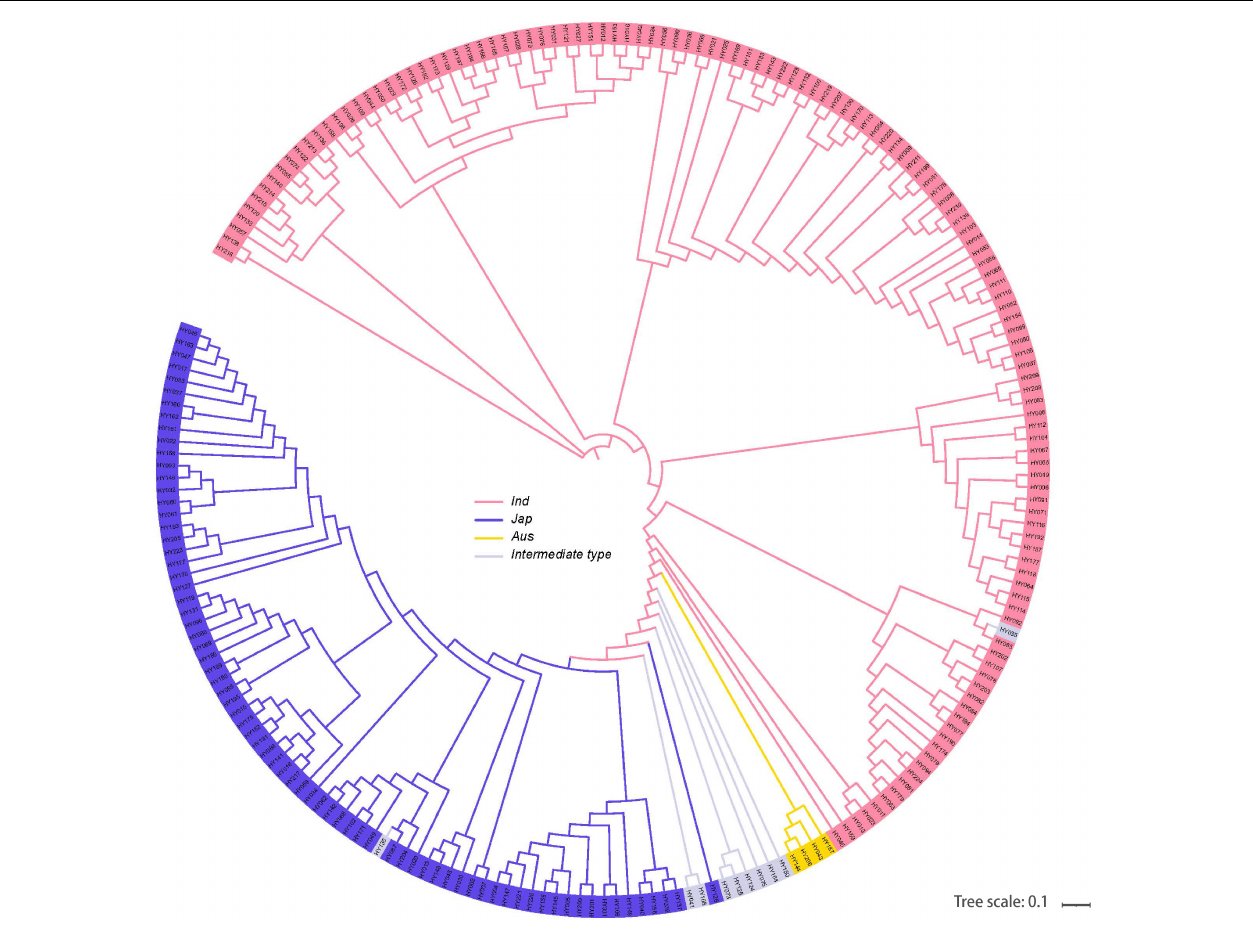
FIGURE 3 | Phylogram of 225 natural varieties showing the divergence. Four main rice subpopulations indicated with different colors: O. indica , O. japonica , Aus , and Intermediate